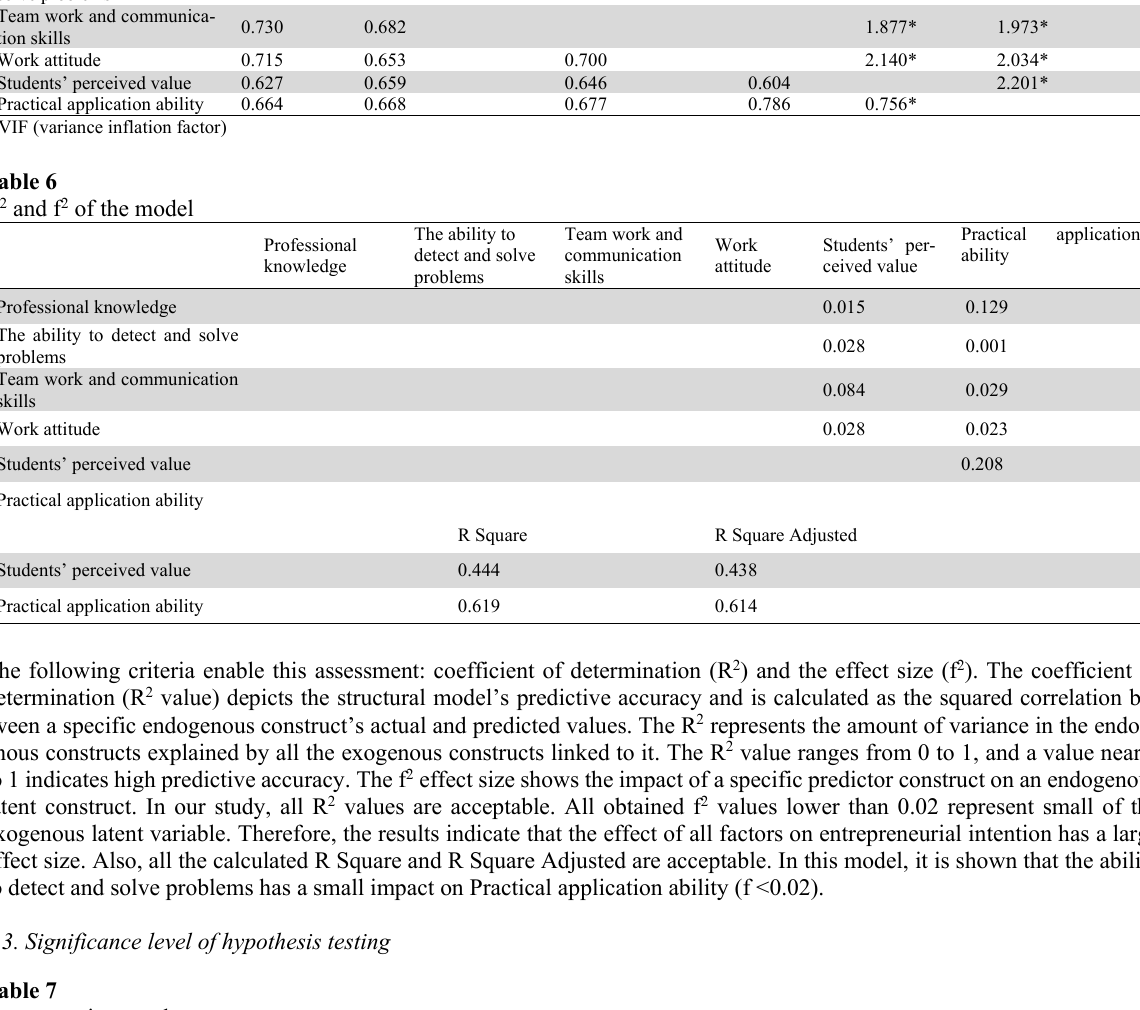
Original Sample